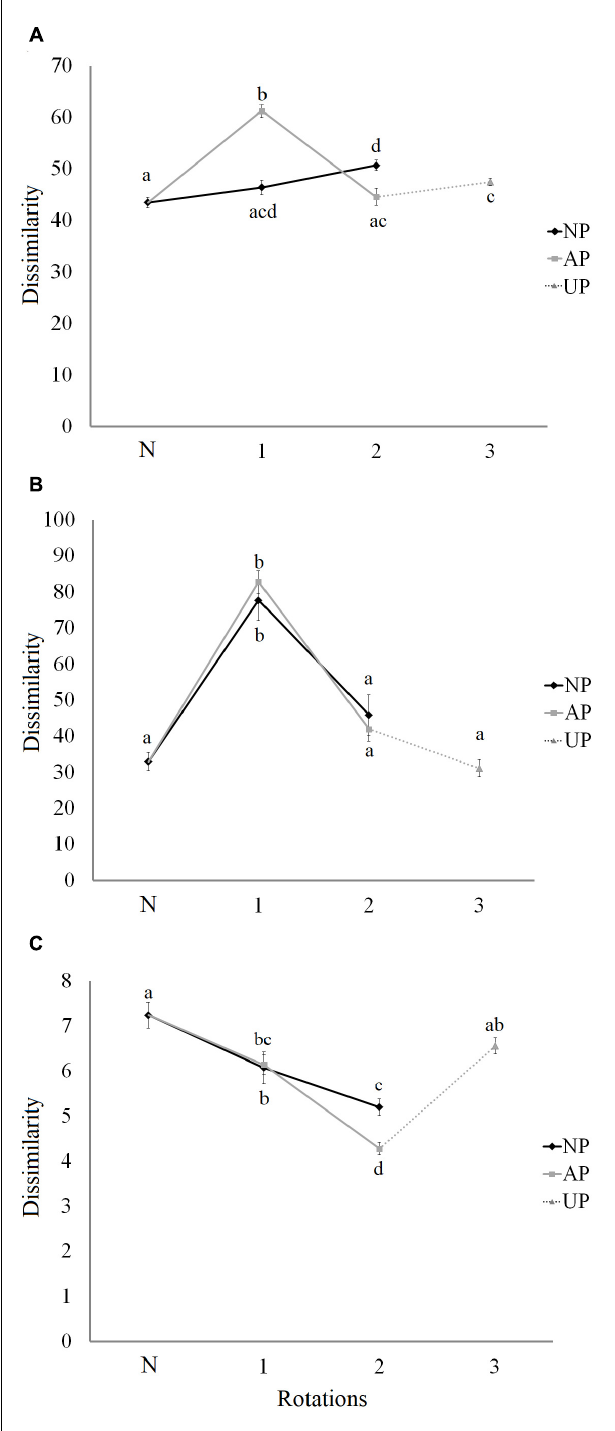
FIGURE 6 | Dissimilarity index for the community of woody plants (A) , herbs (B) , and birds (C) between sites of the same forest class. N in x -axis is Native forest. NP, native forest transformed into pine plantation, AP, agricultural land transformed into pine plantation, UP, unknown previous land use (assumed as agricultural land) transformed into pine plantation. Lower case letters indicate the significance of differences among categories obtained by BH multiple